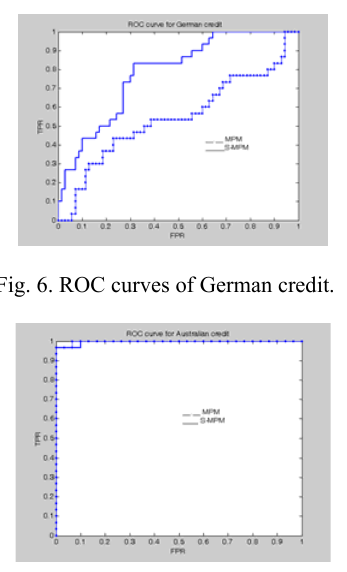
Fig.2. ROC curves of Hepatitis.